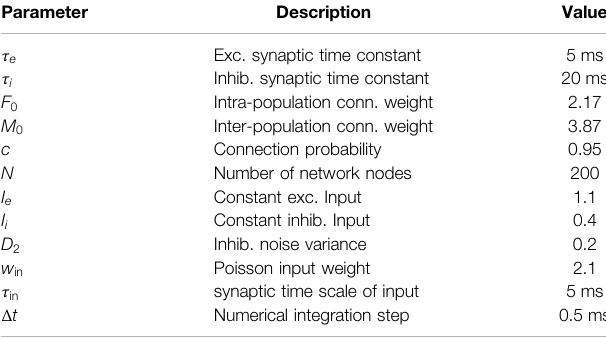
TABLE 1 | Parameter set of model